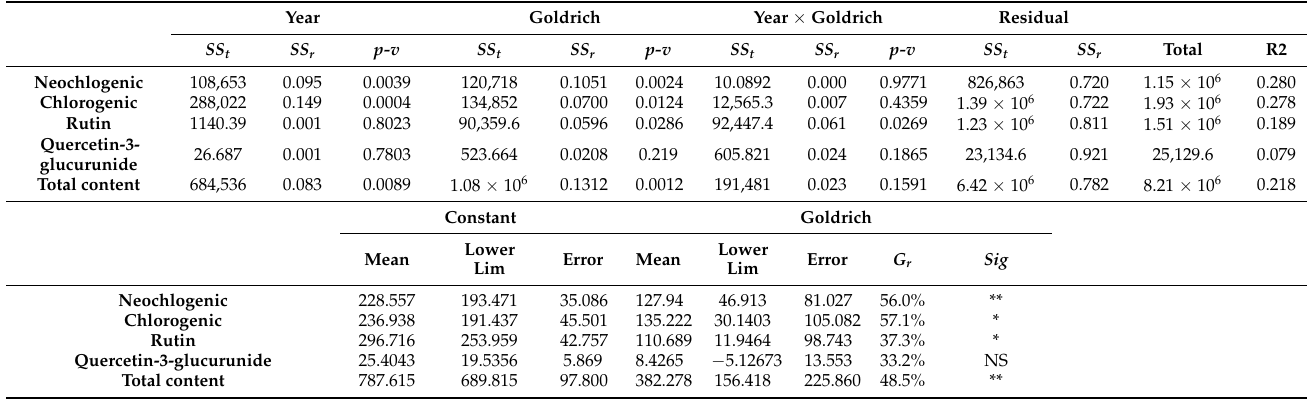
Table 2. ‘Goldrich’ contribution to phenolic content: Sum of squares (SS) and model parameters coefficients. SS r : SS relative; SS t : SS total; p-v : p -value; G r : Goldrich relative; Sig : Significance.